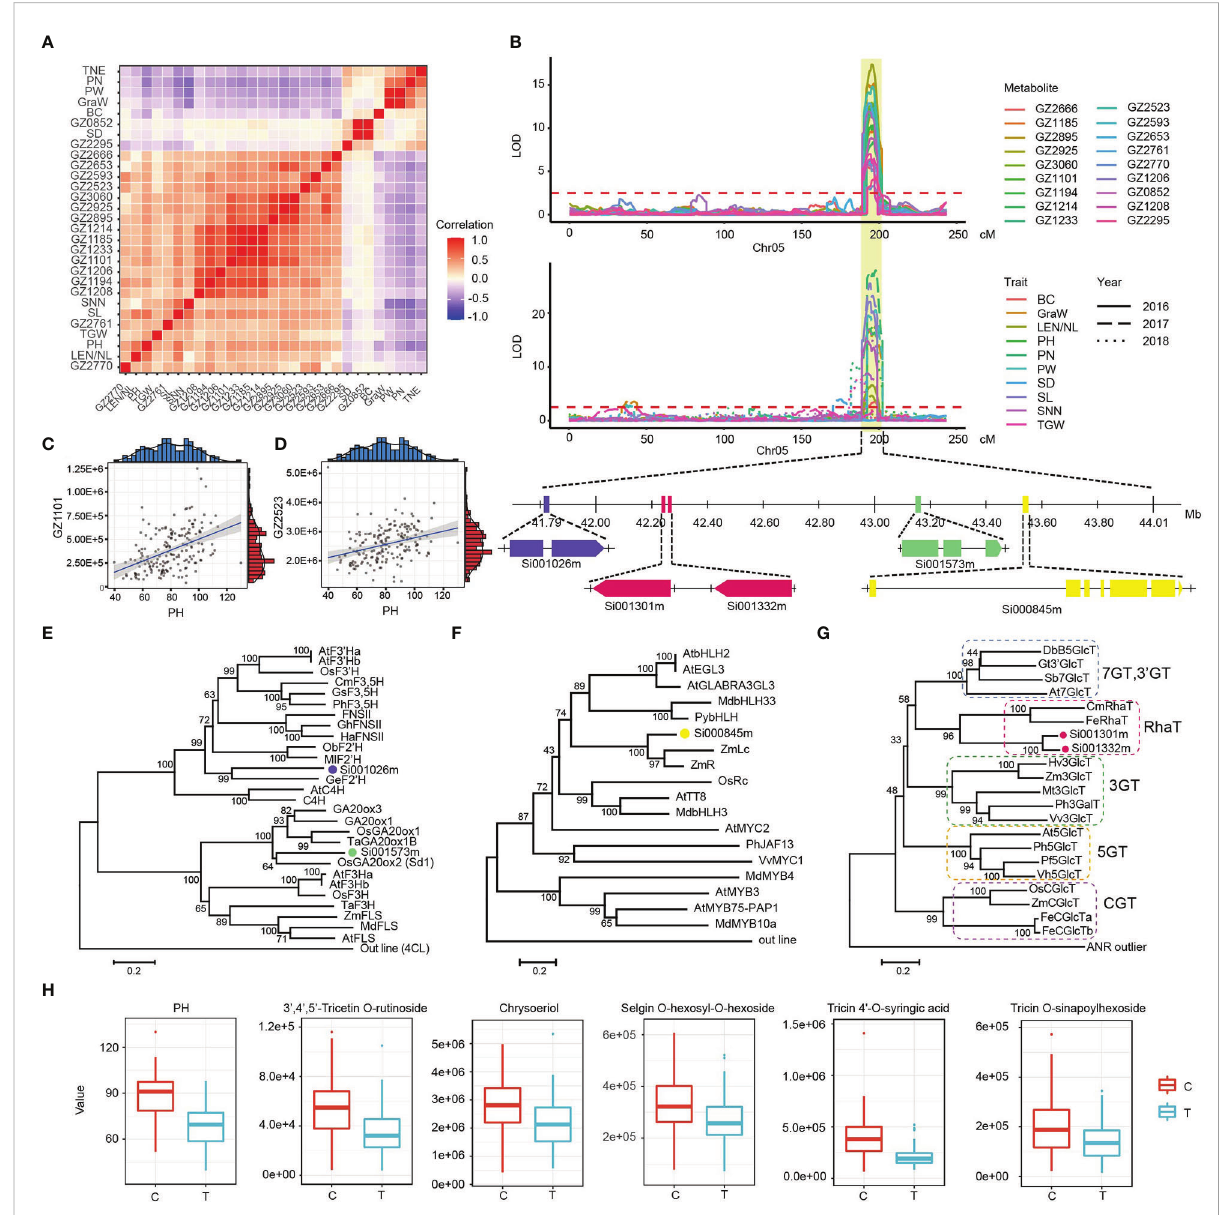
FIGURE 6 Conjoint analysis of fl avonoids and agronomic traits co-localized on chromosome 5. (A) Cluster heatmap of correlations between co-localized fl avonoids and agronomic traits. Pairwise Pearson ’ s correlations are shown in a heatmap, fl avonoids and agronomic traits are sorted according to correlation-based hierarchical cluster analysis. The level of correlation is indicated by red (positive correlation) and blue (negative correlation). (B) LOD curves of QTL mapping of the fl avonoids and agronomic traits on chromosome 5. Below the curve is thegene model of candidate genes. The purple box represents the coding sequence of F2 ’ H , the light green box represents the coding sequence of GA20ox , the pink boxes represent the coding sequence of UGTs , the yellow box represents the coding sequence of Lc. (C, D) Correlation analysis between two metabolites (GZ1101 and GZ2523) and PH. (E-G) An unrooted phylogenetic tree of the candidate genes protein was constructed as described in Methods. Bootstrap values >70% (based on 1000 replications) are indicated at each node (bar: 0.2 amino acid substitutions per site). (H) The effect of different alleles on the content of some fl avonoids and PH. GZ1206, Chrysoeriol; GZ2593, Syringetin 7-O-hexoside; GZ2666, Selgin O- hexosyl-O-hexoside; GZ2761, 3 ’ ,4 ’ ,5 ’ -Tricetin O-rutinoside; GZ2653, Tricin -O-(syringyl alcohol) ether 5-O-hexoside; GZ1185, Tricin O-malonyl rhamnoside; GZ1208, Syringetin; GZ2770, Tricin O-sinapoylhexoside; GZ3060, Tricin 4 ’ -O-syringic acid; GZ0852, Apigenin 7-rutinoside; GZ1194, Tricin; GZ1214, Tricin 4 ’ -O- b -guaiacylglycerol; GZ1233, Tricin O-oxalic acid O-coumaroyl shikimic acid; GZ1101, Tricin O-glycerol; GZ2925, Tricin 4 ’ -O-syringyl alcohol; GZ2627, Hydroxymyricetin; GZ2895, Tricin O-phenylformic acid; GZ2954, Tricin -O-syringyl alcohol